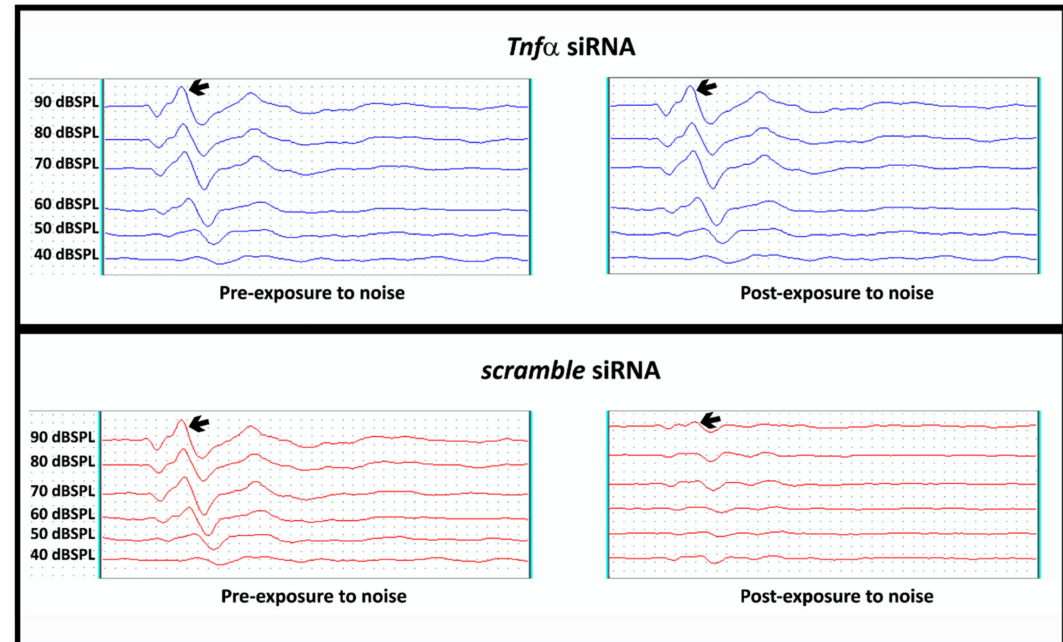
Figure 4. Representative analysis of the electrophysiological threshold shift (in dBSPL) in the cochleae of rats previously submitted (S, n = 20) or not submitted (NS, scramble, n = 20) to TNF α blockade by gene silencing before and after noise exposure. Narrow represents wave II, which was used to determine the threshold shift.